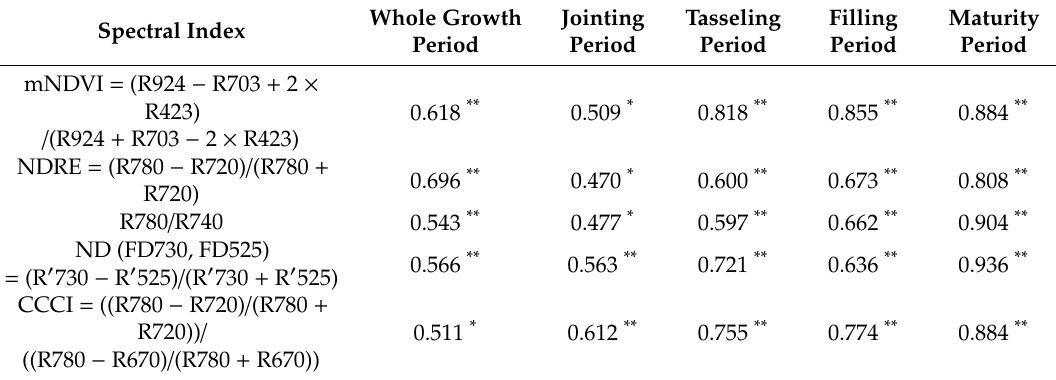
Table 8. Correlation coe ffi cients between corn canopy nitrogen concentration and spectral indices